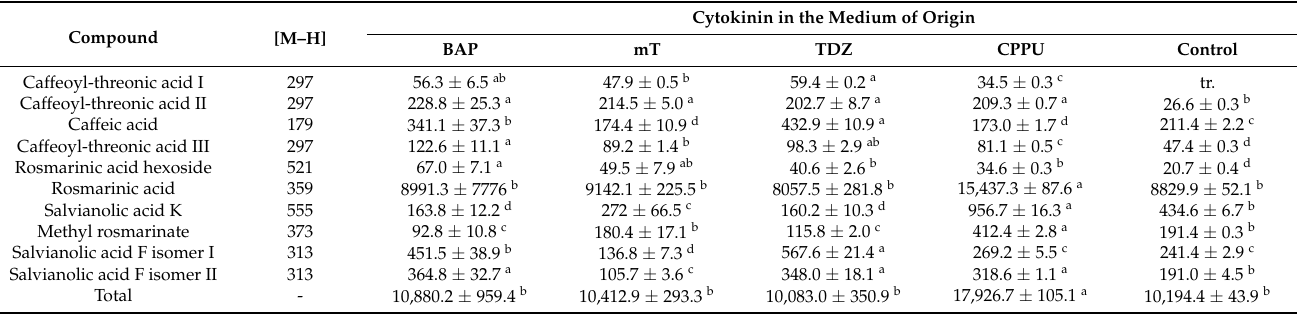
Table 4. Quantitative analysis of polyphenolic compound [ µ g/g DW] in in vitro regenerated shoot line obtained in the presence of different cytokinin and control shoot culture of S. bulleyana after year (passage 10). Cytokinin in the Medium of Origin Compound [M–H]